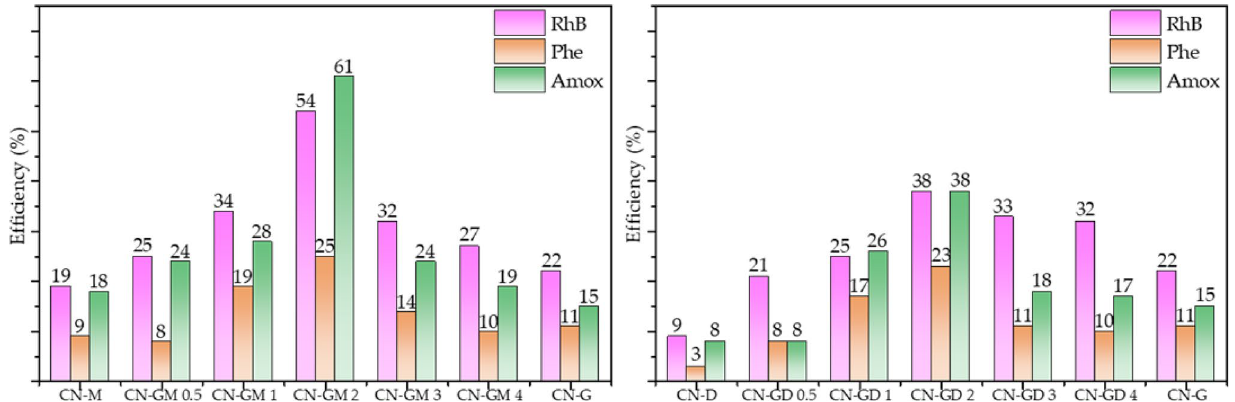
Figure 4. Photocatalytic degradation of RhB, phenol (Phe) and amoxicillin (Amox) after 120 min of visible light irradiation.